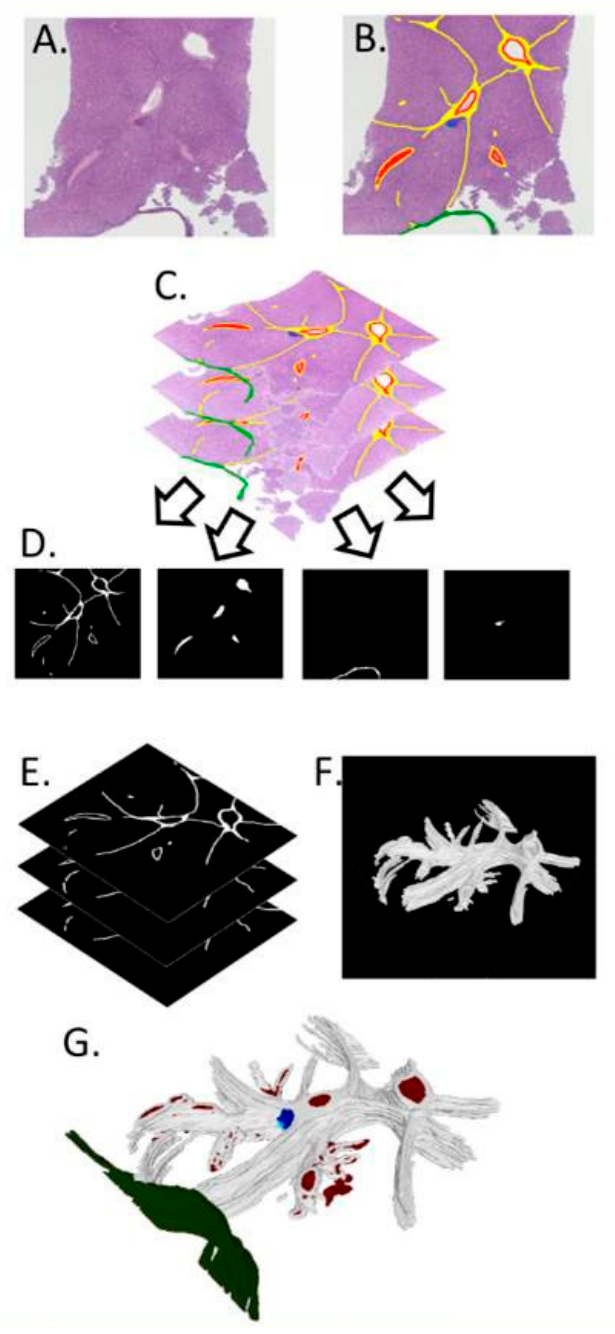
Figure 2. Three-dimensional reconstruction steps from serial sections and image acquisition ( A ), identification of structures of interest ( B ), registered images ( C ), visualization of two-dimensional binary matrices ( D ), three-dimensional matrix formation ( E ), creation of a mesh over the voxels ( F ), and final three-dimensional mesh visualization ( G ).